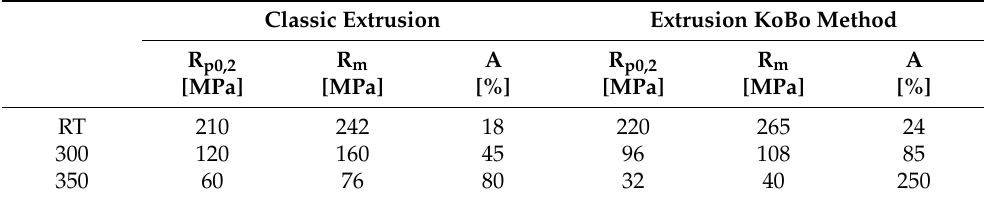
Table 5. Results of tensile testing of the investigated alloy at increased RT, 300 ◦ C, and 350 ◦ C after KoBo method. Temperature ( ◦